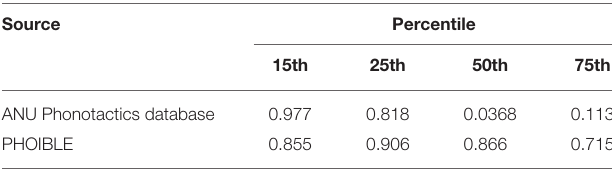
Frontiers in Psychology |